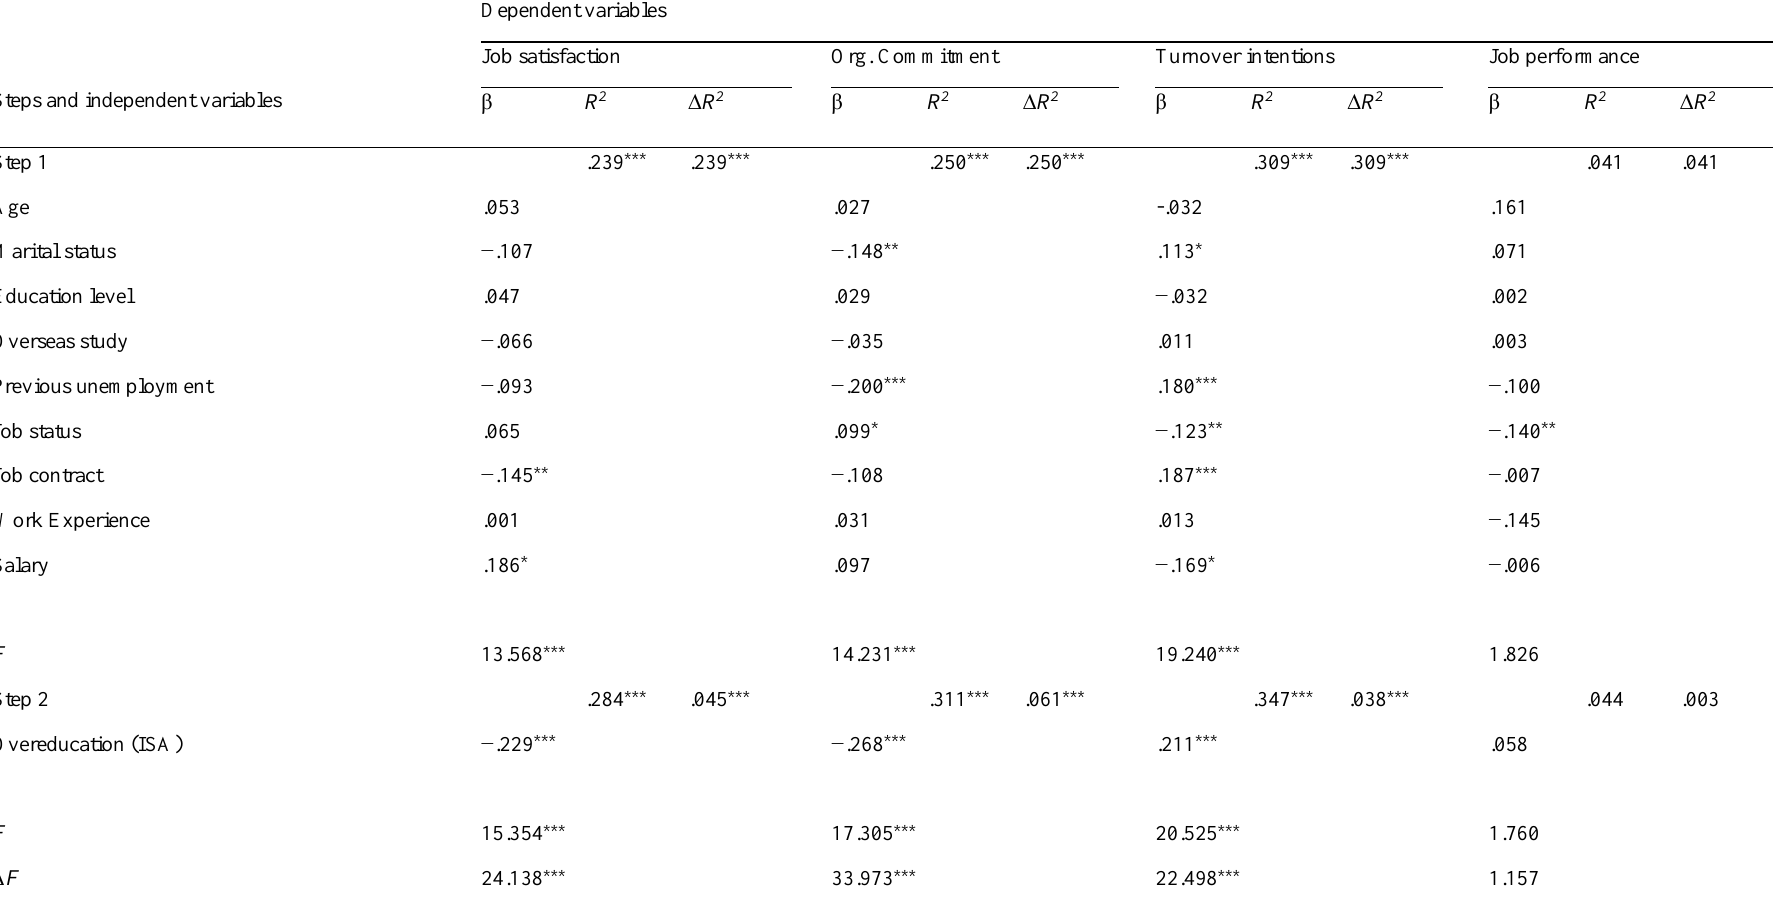
Table 3: Hierarchical multiple regression analyses summary for overeducation (ISA) predicting job outcomes and